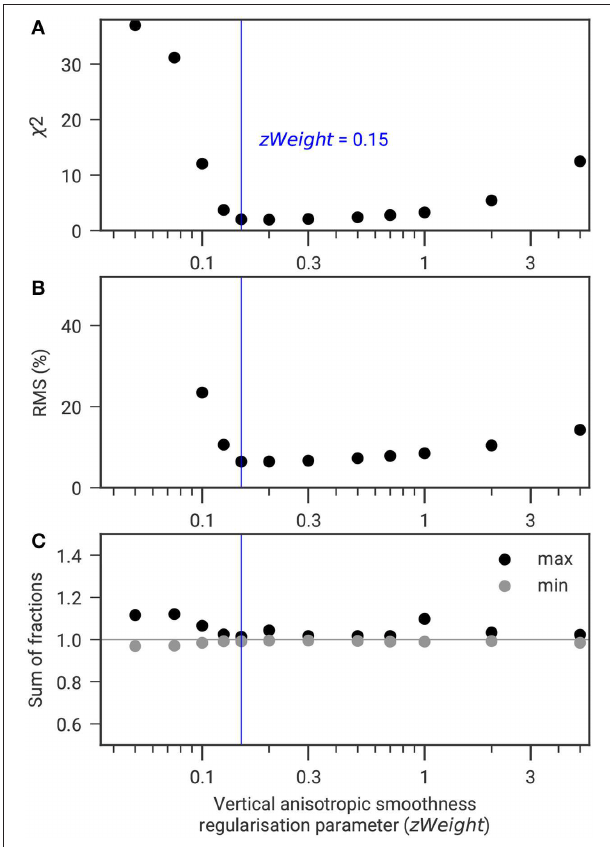
FIGURE 6 | Scatter plot of the regularization parameter β constraining the sum of fractions to be unity against (A) χ 2 , (B) RMS, and (C) minimum and maximum sum of the four fractions to determine the most adequate value of β for the Cervinia field site (for constant α and zWeight).